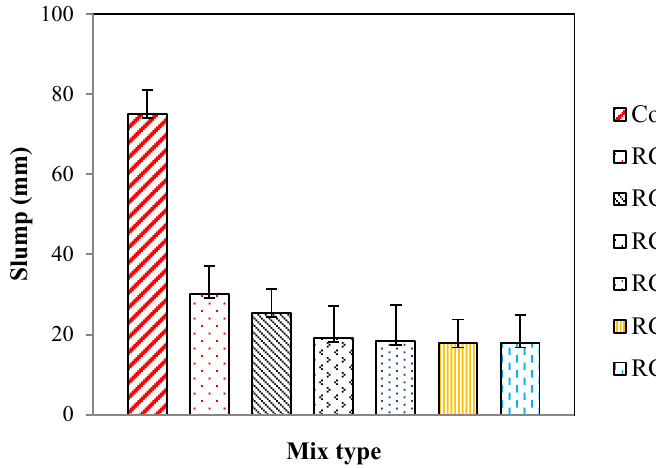
Figure 4. Slump of fresh concrete for all samples.